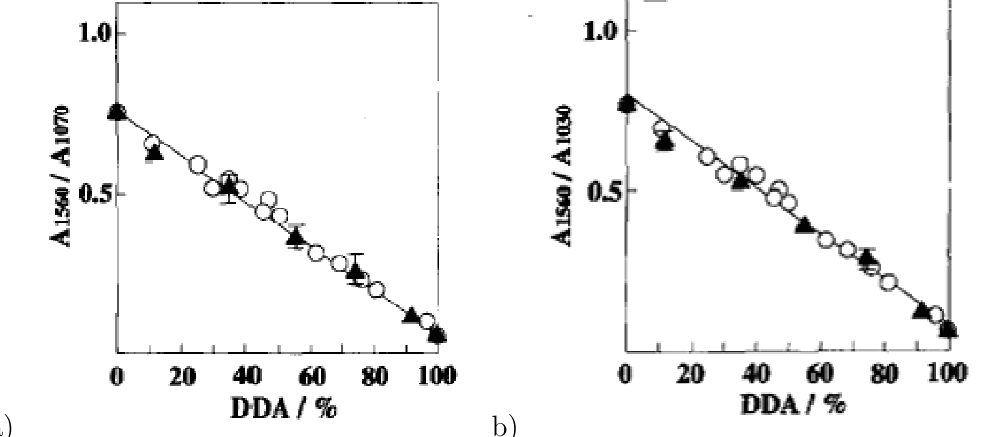
Fig. 4 Determination of deacetylation degree: a) relationship between deacetylation degree and relative absorbance of A 1560 /A 1070 b) relationship between deacetylation degree and relative absorbance of A 1560 /A 1030